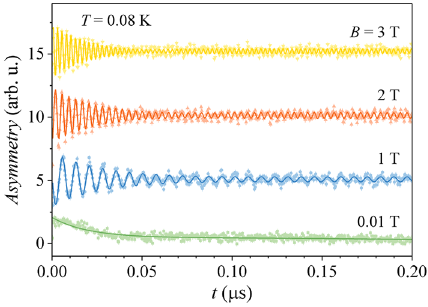
80 mK in selected magnetic fields. For clarity, ∼